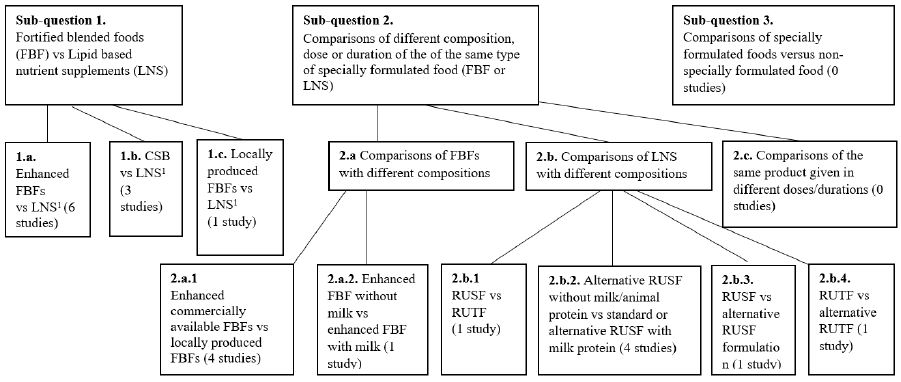
Figure 1. Flowchart showing the number of studies per comparison group.